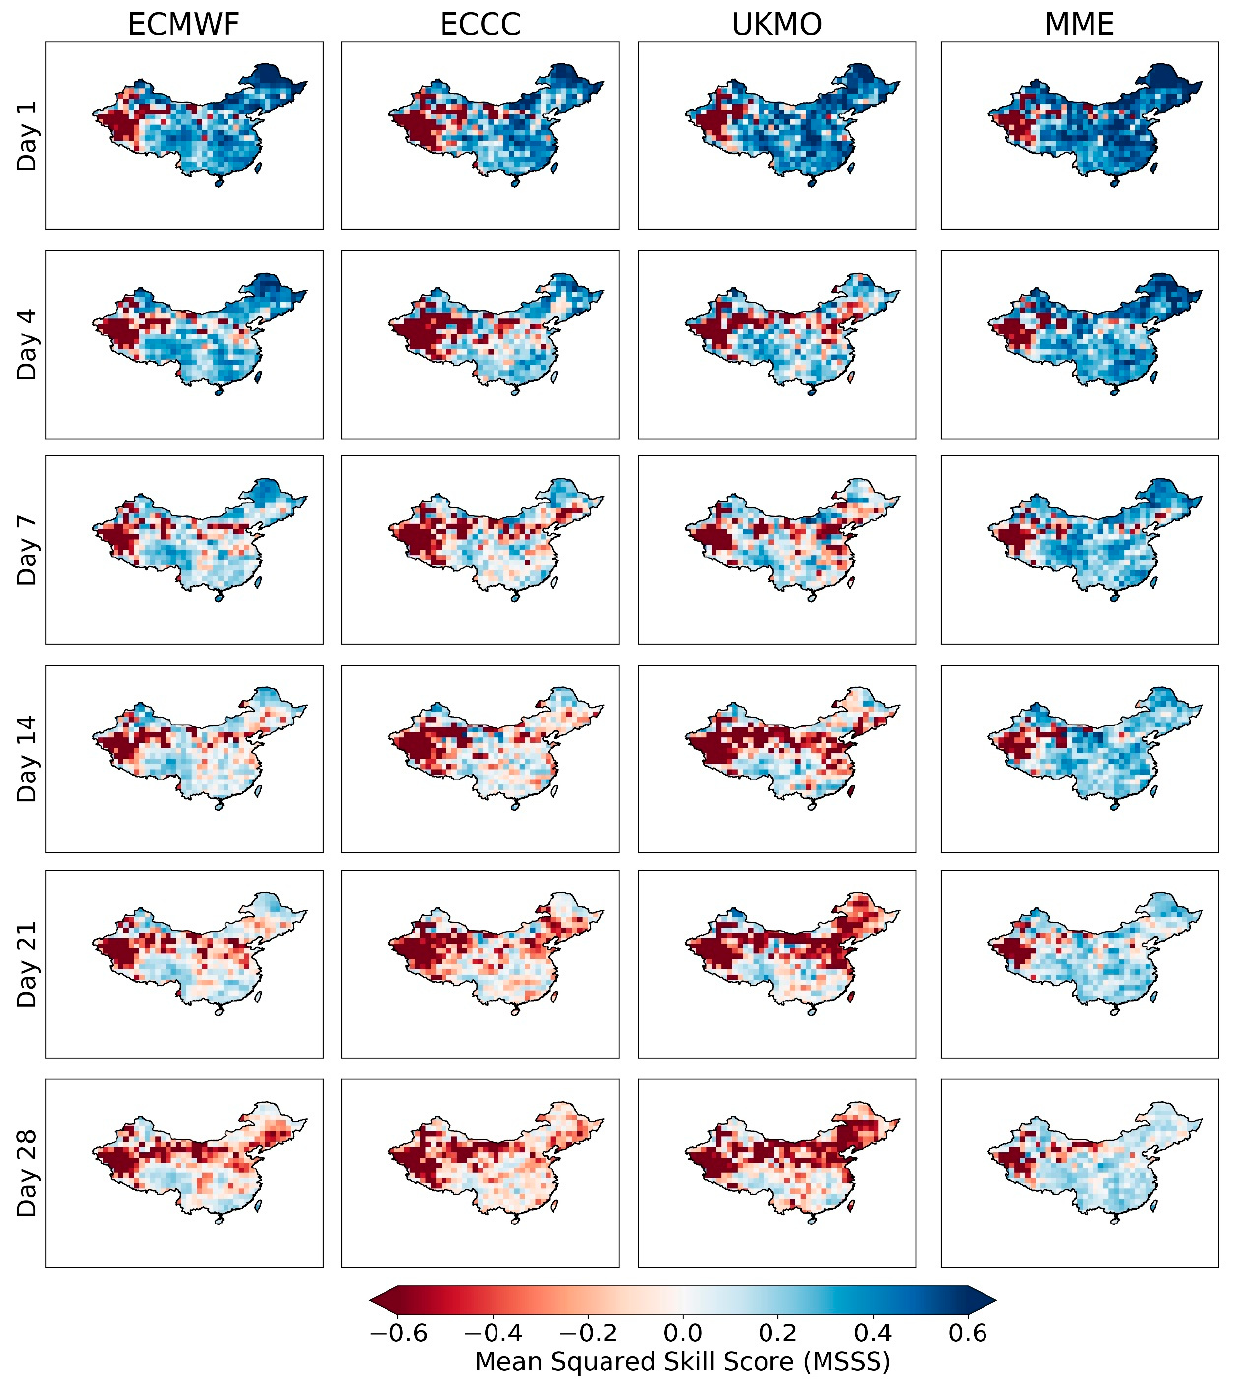
Figure 3. Mean squared skill score of daily forecasts at different lead times (Day 1, 4, 7, 10, 14, 21, 28) of the ECMWF model, the ECCC model, the UKMO model, and the MME model over China during the boreal summer monsoon.